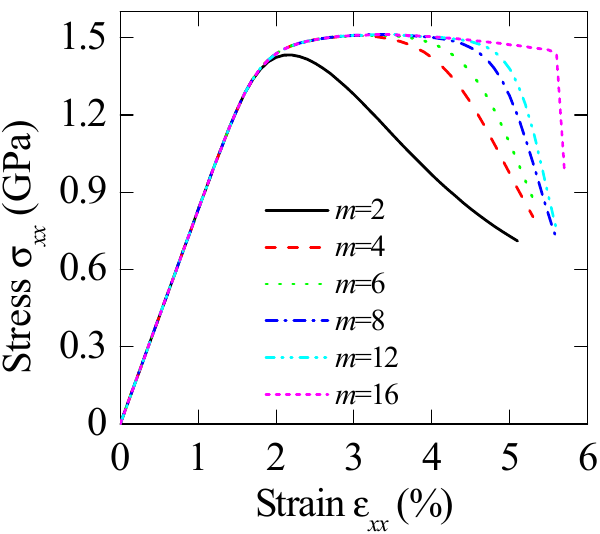
Figure 4. Comparisons of the macroscopic stress–strain relation between the prediction and experiments for BMGCs with different particle concentrations [20]. ε 0 = 0.11 and m = 8 are adopted in the computation.